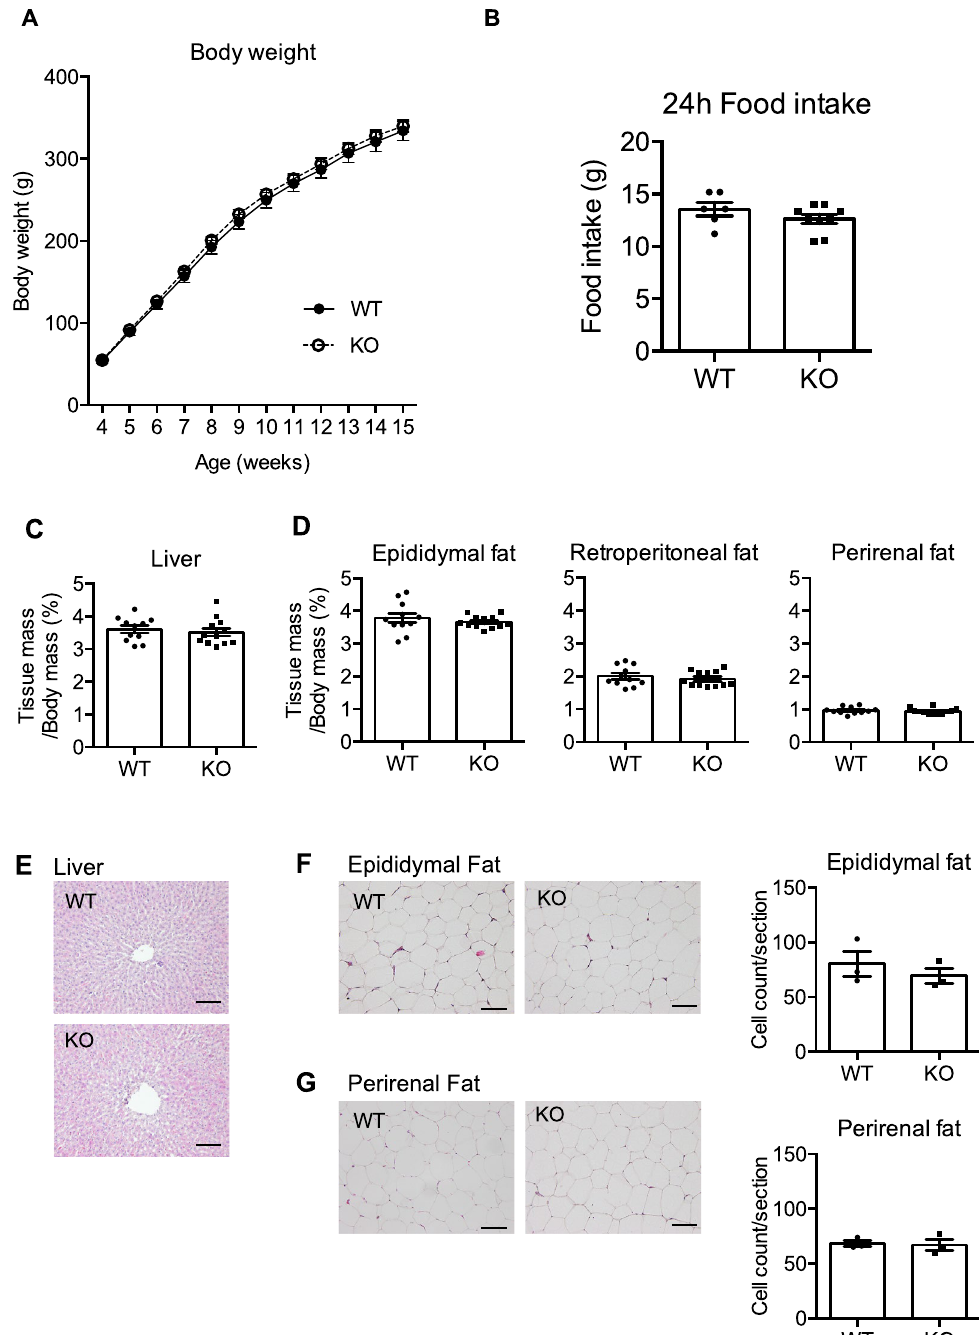
Figure 5. Body weights of male WT and NMU KO rats fed a high fat diet. ( A ) Growth curve of WT rats (n = 11) and KO rats (n = 12) from 4 to 15 weeks of age. ( B ) Food intake of free-feeding rats at 15 weeks of age (WT n = 22, KO n = 19). ( C ) Percentage of the liver mass content in WT and KO rats (WT n = 11 KO n = 12). ( D ) Percentage of the visceral fat mass content in WT and KO rats (WT n = 11 KO n = 12). ( E ) Representative photographs of HE-stained liver sections of WT and KO rats. Scale bar: 100 µm. ( F ) Representative photographs of HE-stained sections of epididymal fat tissue and the cell count per section (n = 3 per group). Scale bar: 100 µm. ( G ) Representative photographs of HE-stained sections of perirenal fat tissue and the cell count per section (n = 3 per group). Scale bar: 100 µm. All data represent means ±